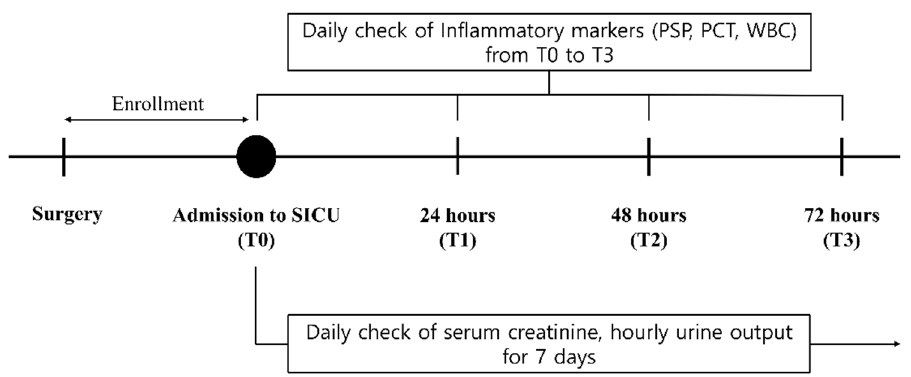
Figure 2. Schematic diagram of data collection.